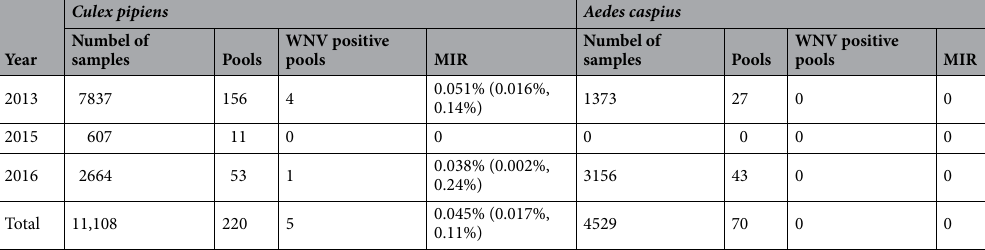
Table 5. WNV surveillance in mosquitoes in Kashgar Region,